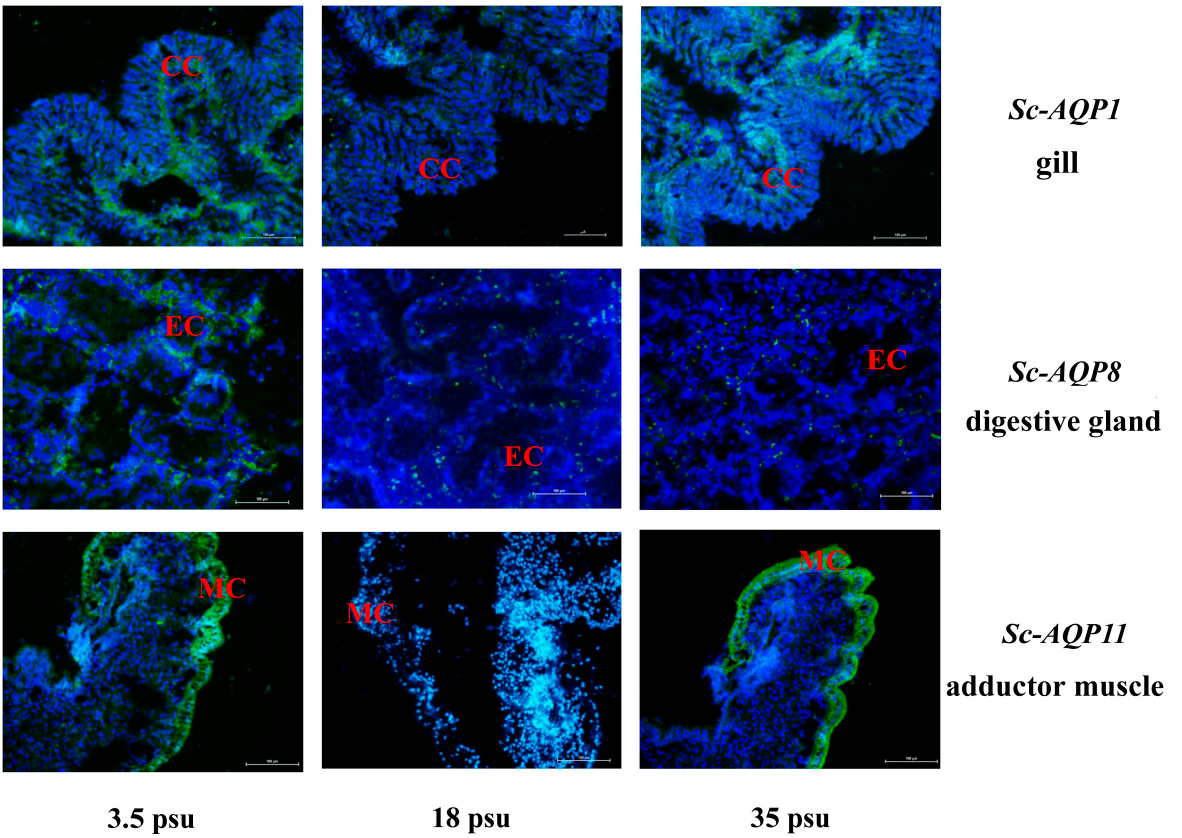
Figure 9. Immunofluorescence of Sc ‐ AQP1 , Sc ‐ AQP8 , and Sc ‐ AQP11 in different tissues. The positive signal of Sc ‐ AQPs genes is indicated in green, and nuclei were stained with DAPI in blue. CCs, columnar cells. ECs, endothelial cells. MCs, muscle cells. Scale bars are 100 μ m.